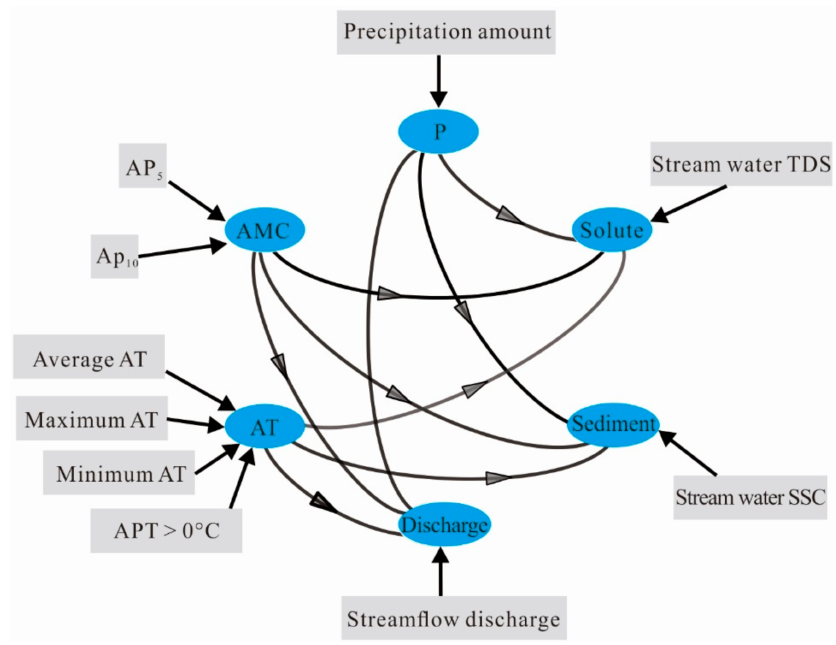
Figure 2. The path diagram of partial least-squares path modeling includes manifest (rectangles) and latent (ovals)